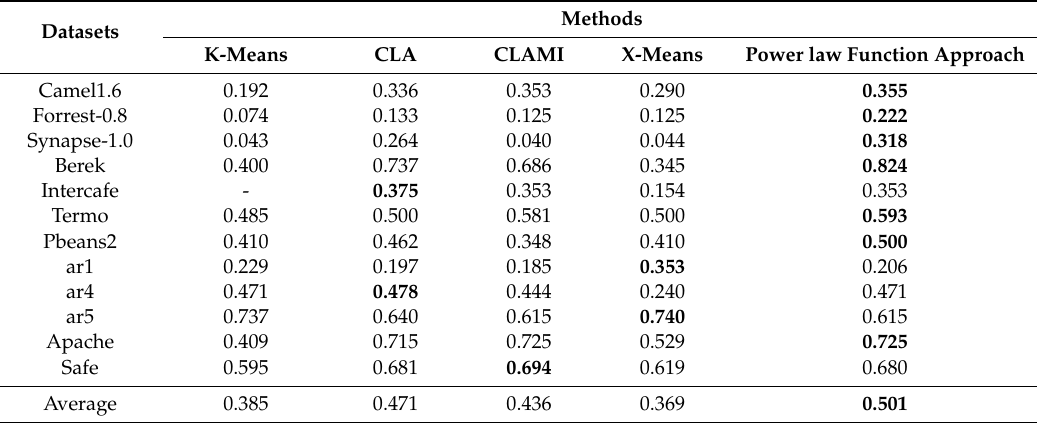
Table 6. Comparisons of F-measure results between the proposed approach and other methods.